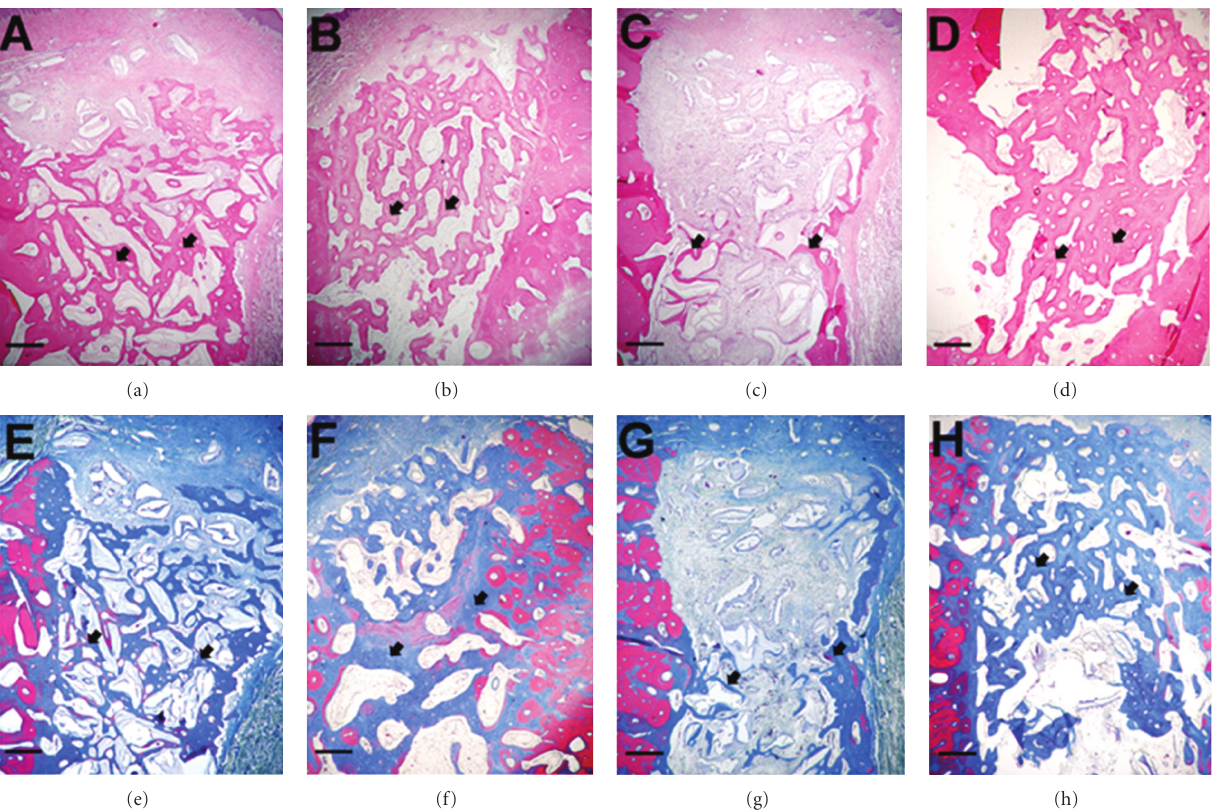
Figure 4: Representative hematoxylin-eosin ((a)–(d)) and Gomori trichrome stain ((e)–(h)) histological images of extraction sockets from the 4th premolar after six weeks of healing time. (a) and (e), bovine xenograft particulate and collagen plug (X), (b) and (f), bone putty only (Bp), (c) and (g), xenograft particles sandwiched between layers of bone putty placed in the coronal and apical aspect, (Bp-X-Bp), and (d) and (h), a 3: 1 mixture by weight of bone putty and xenograft particles, respectively (3Bp-X). Arrows highlight newly formed bone between xenograft particles or in Bp only grafted sockets (b) and (f). Scale bar = 400 microns, 20x